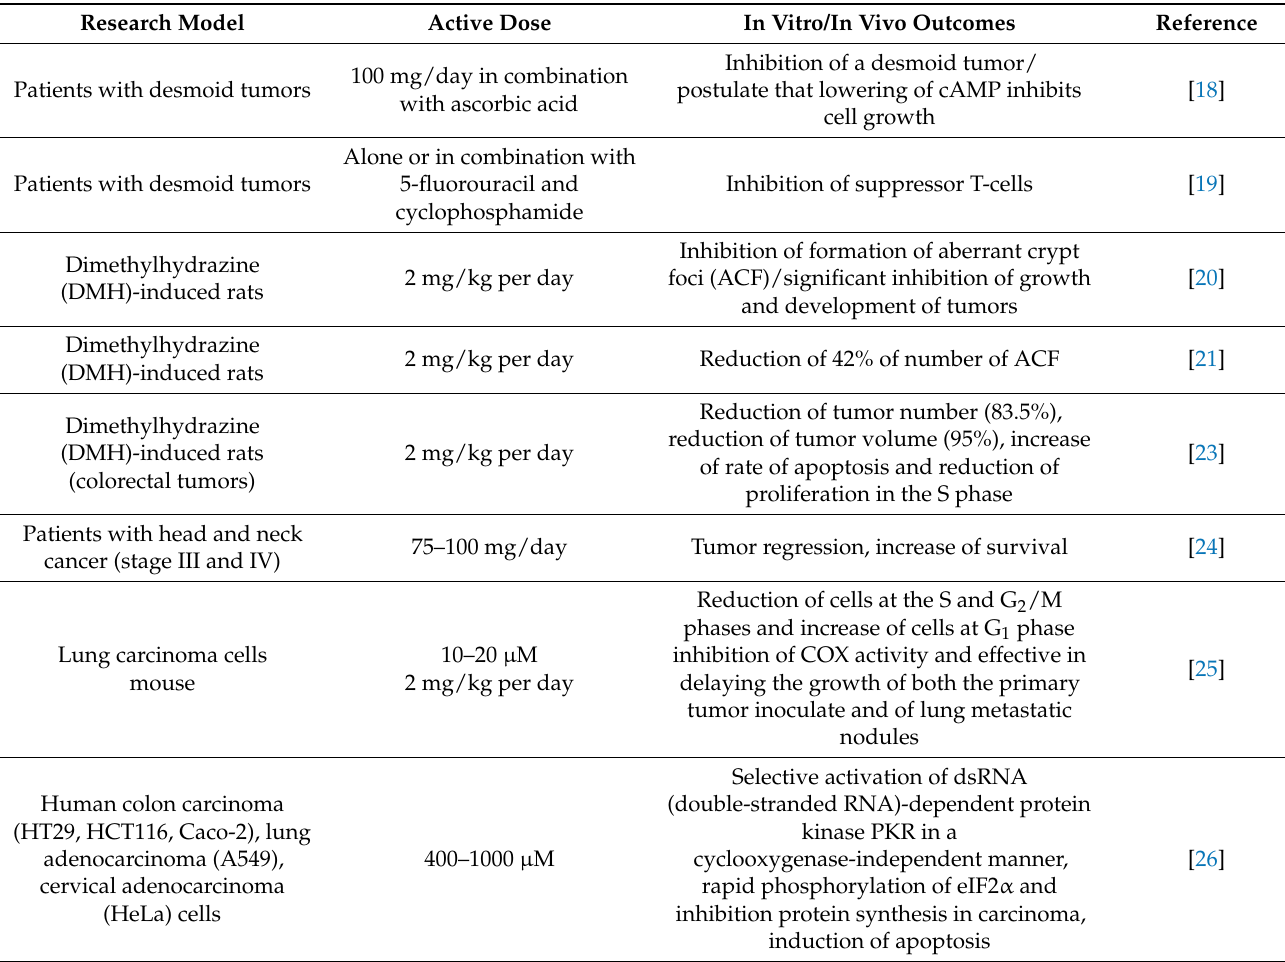
Table 1. Anticancer activity of indomethacin and its mechanism of action in the in vitro and in vivo models. Research Model Active Dose In Vitro/In Vivo